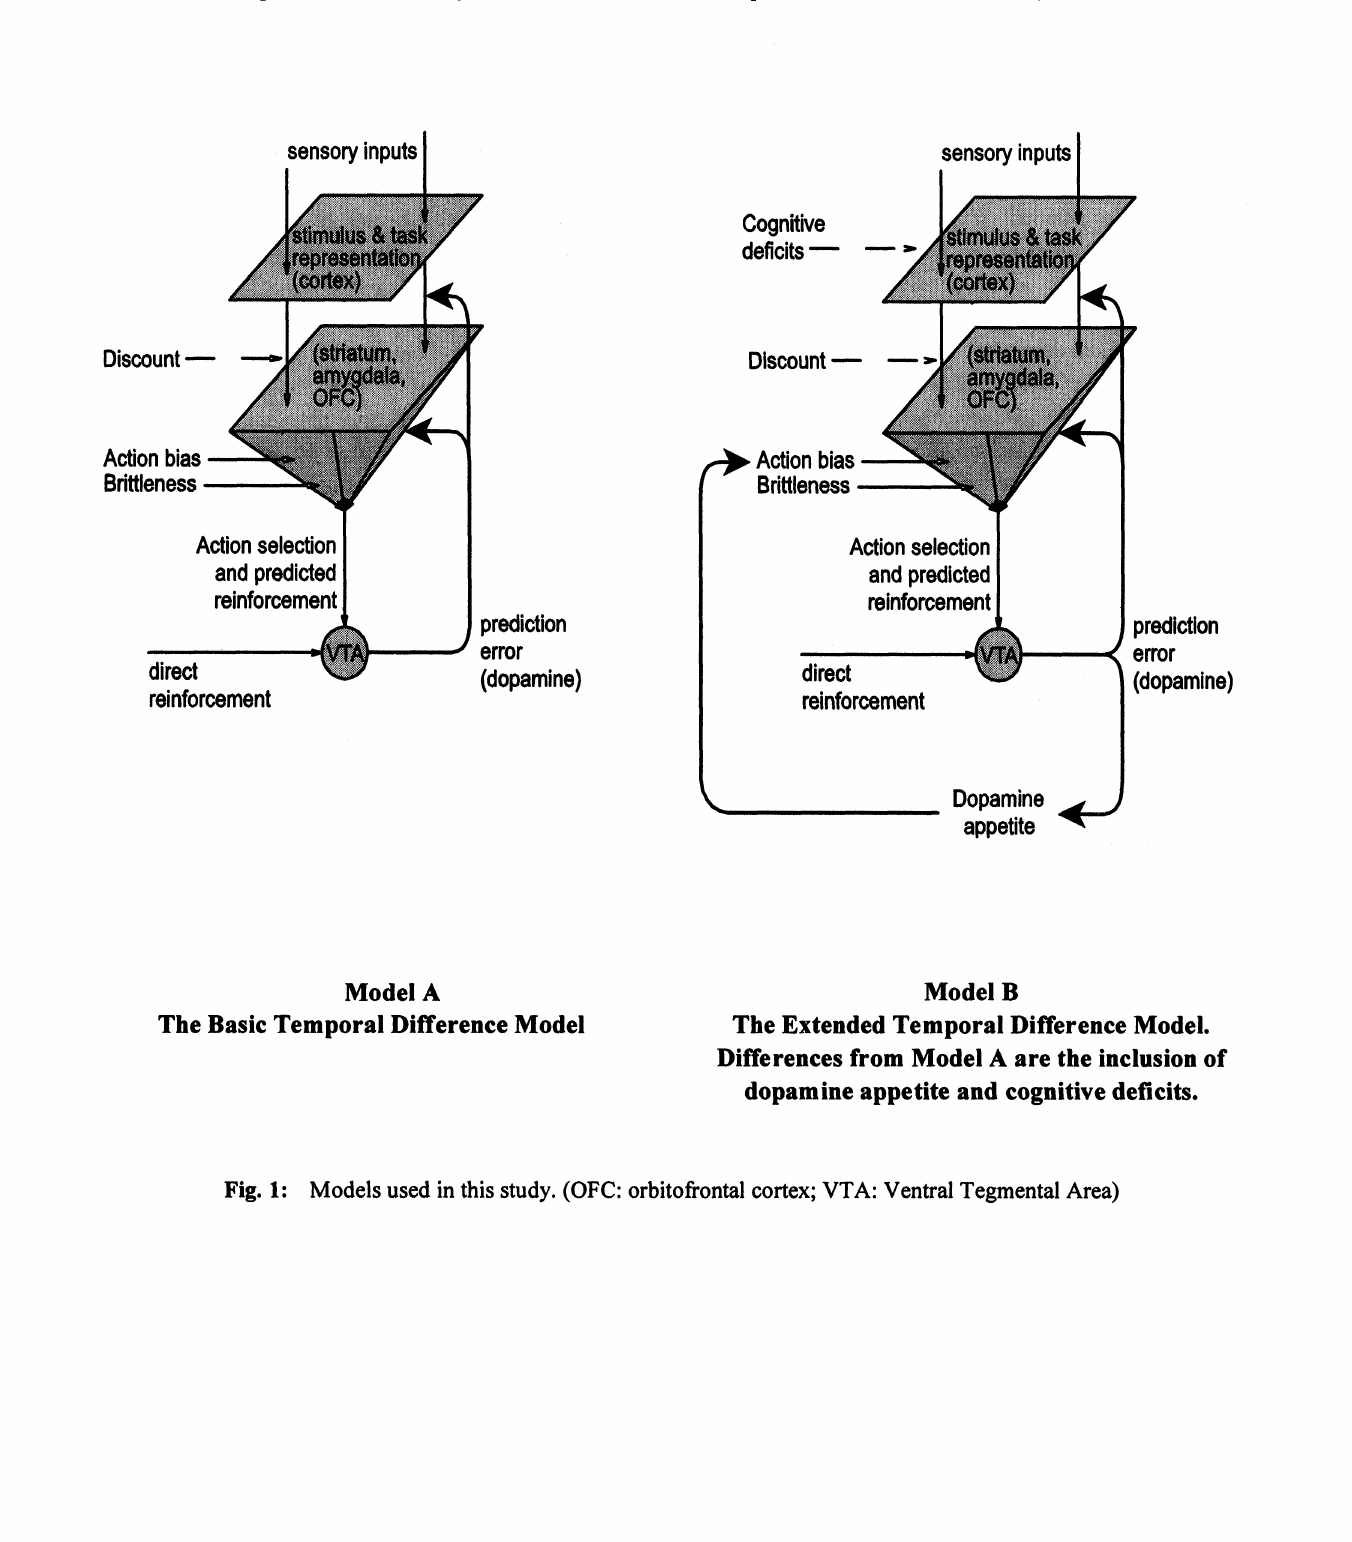
Fig. 1: Models used in this study. (OFC: orbitofrontal cortex; VTA: Ventral Tegmental